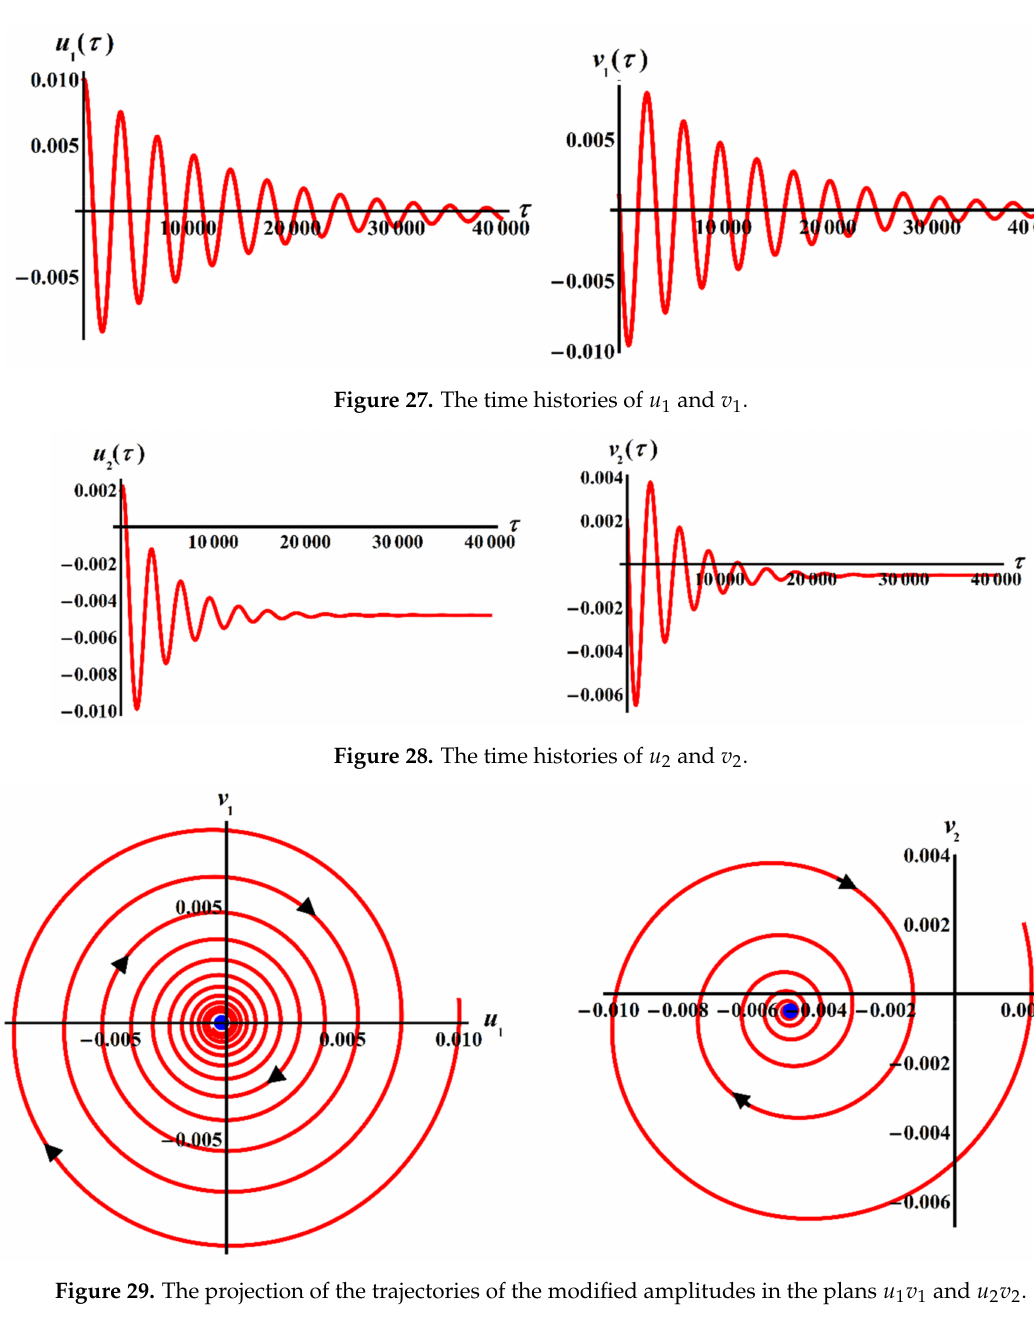
Figure 29. The projection of the trajectories of the modified amplitudes in the plans u 1 v 1 and u 2 v 2